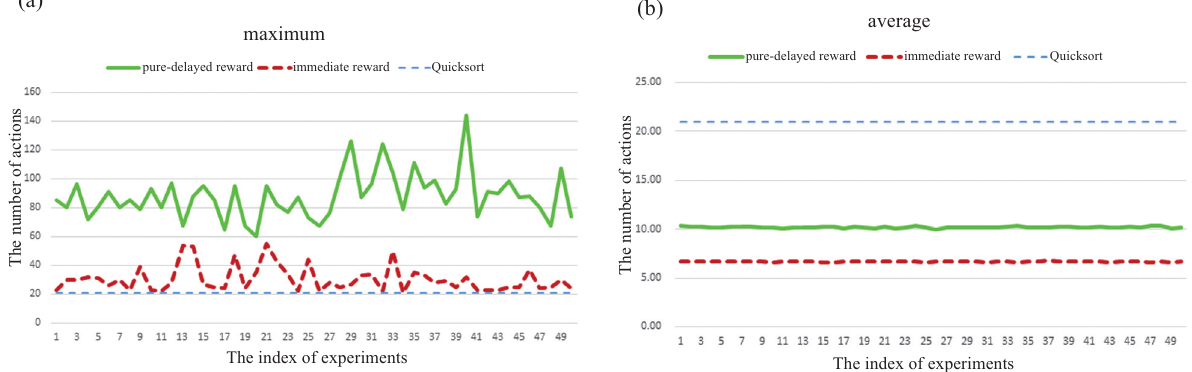
Fig. 6. Detailed results of maximum (a) and average (b) values to sort 7! lists for 50 times regarding pure­delayed reward, immediate reward, and Quicksort.